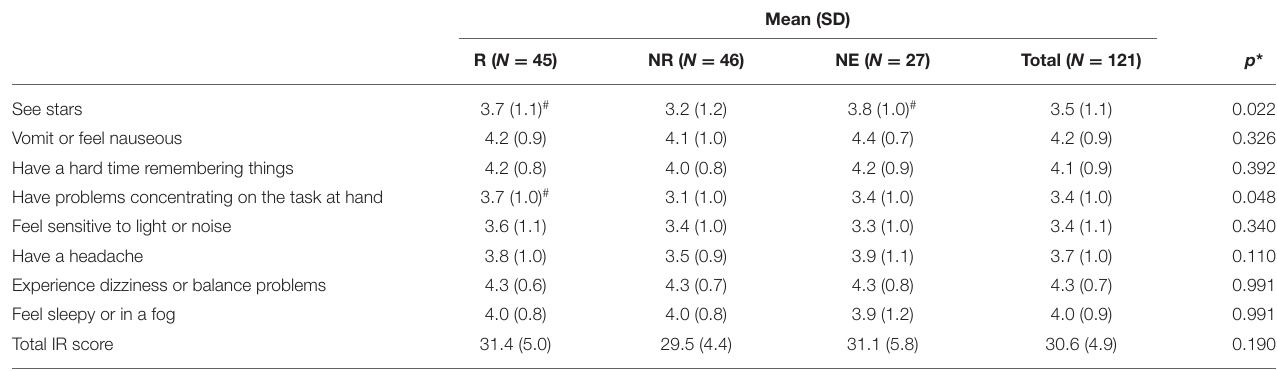
TABLE 3 | Intention to report